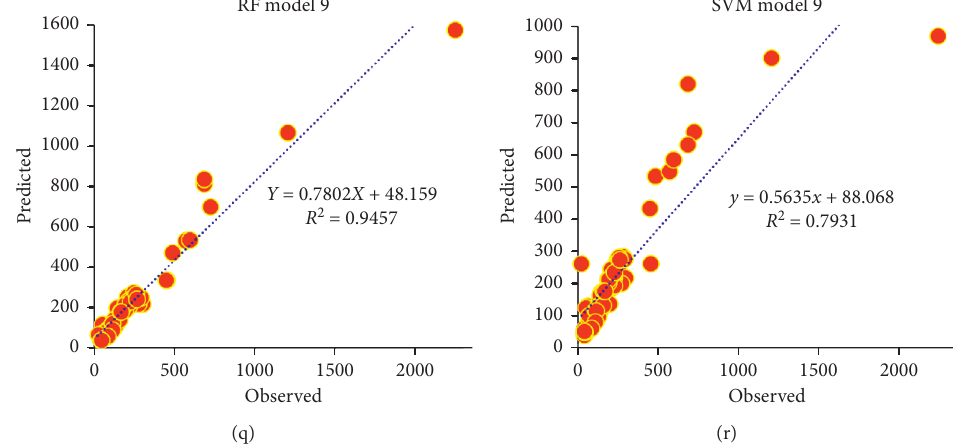
Figure 7: The scatter plots of the RF and SVM models over the testing phase for all investigated input